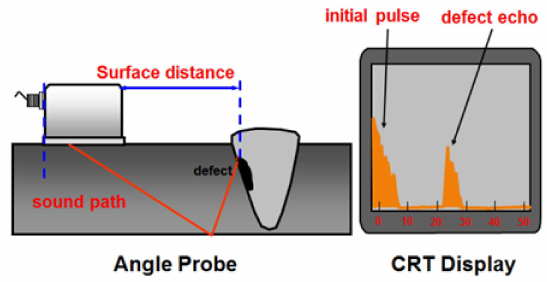
Figure 9. UT Methodology